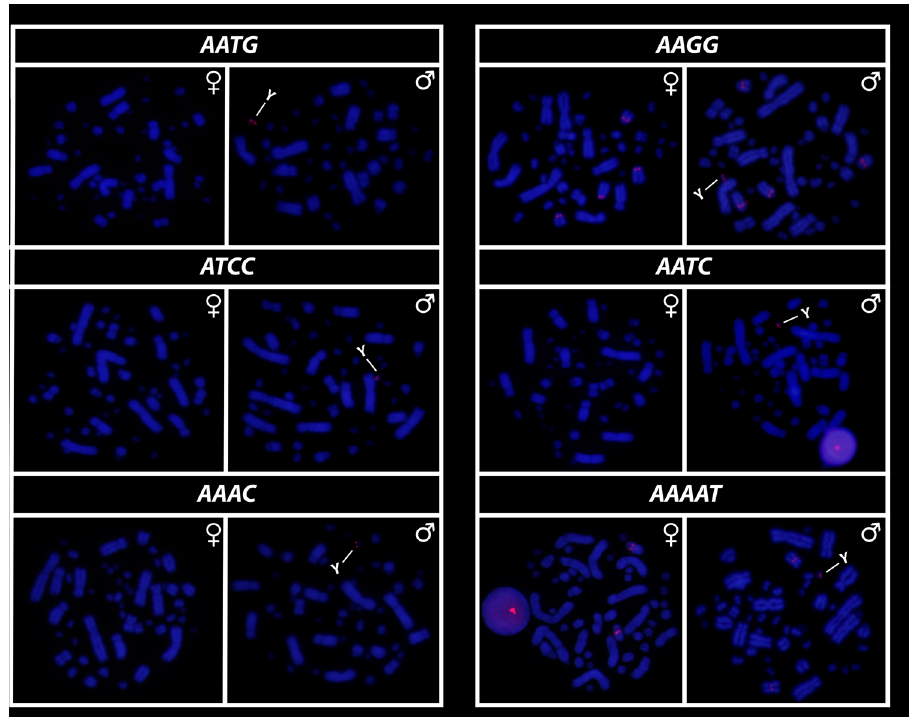
Figure 7. Mapping of SSRs on the chromosomes of males and females of Chelus orinocensis , with highlights to the particular accumulation on the mic Y